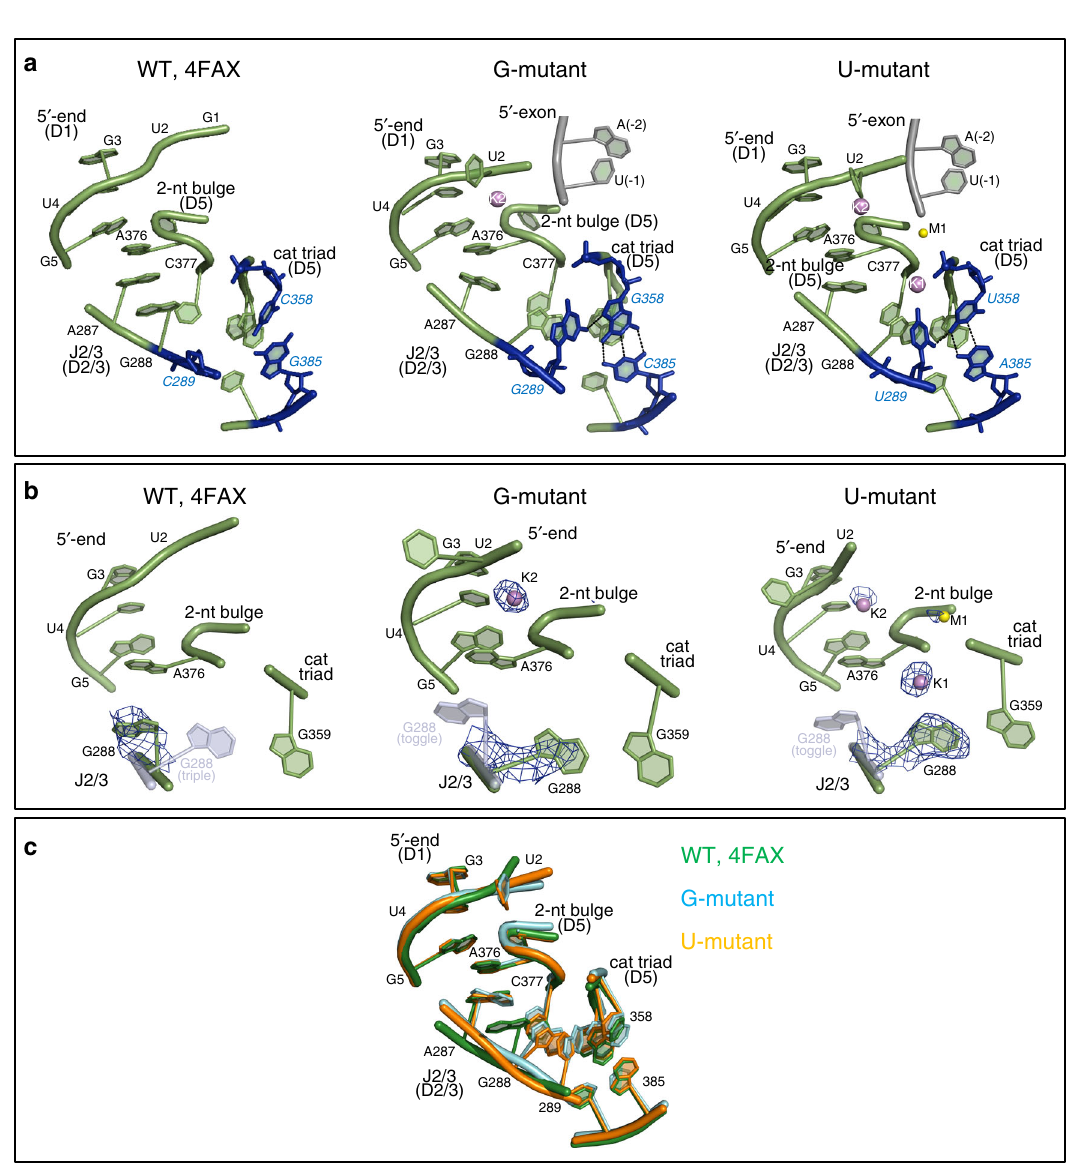
Fig. 3 Crystal structures of the intron in sodium and magnesium. a From left to right: Active site of wild type (WT; PDB id: 4FAX), G-mutant, and U- mutant. Active site elements are depicted as in Fig. 2a. b F o − F c simulated-annealing electron density omit-maps calculated by omitting J2/3 residues (nt 287 – 289) and the M1 – M2 – K1 – K2 metal cluster from each of the structures depicted in ( a ). Positive electron density peaks within 3 Å from the omitted atoms are depicted as blue mesh at a contour level of 3 σ . For the wild-type structure (left), the triple helix conformation of G288 is depicted as semi- transparent light blue cartoon representation, the M1 – M2 metals as semi-transparent yellow spheres, and the K1 – K2 metals as semi-transparent violet spheres (all using coordinates from PDB id: 4FAR). Analogously, the toggled conformation of G288 and unresolved metals of the cluster are depicted as semi-transparent representations for the G- and U-mutant (middle and right panels, using coordinates from PDB id: 4FAX for G288 and 4FAR for unresolved metals). c Superposition of the active sites of the structures depicted in ( a